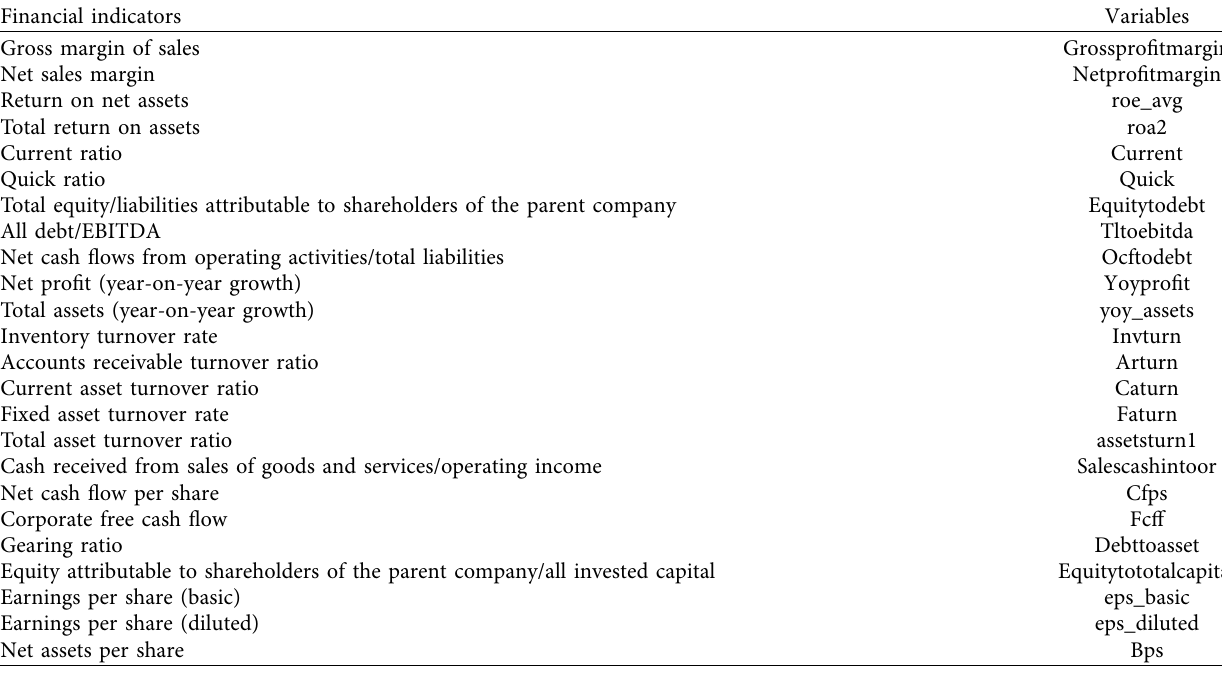
Table 1: Actual financial indicators